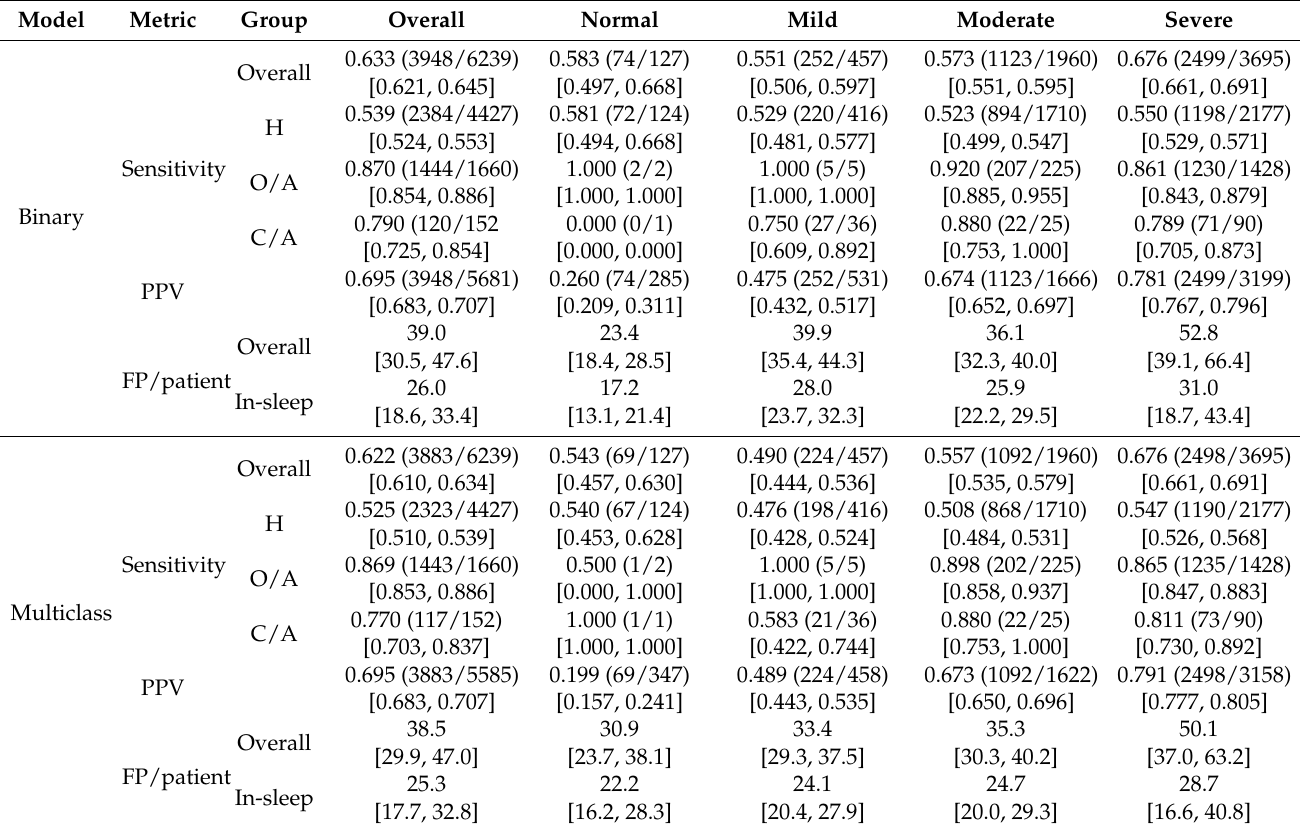
Table 3. Global event detection performance in the overall study population and OSA severity